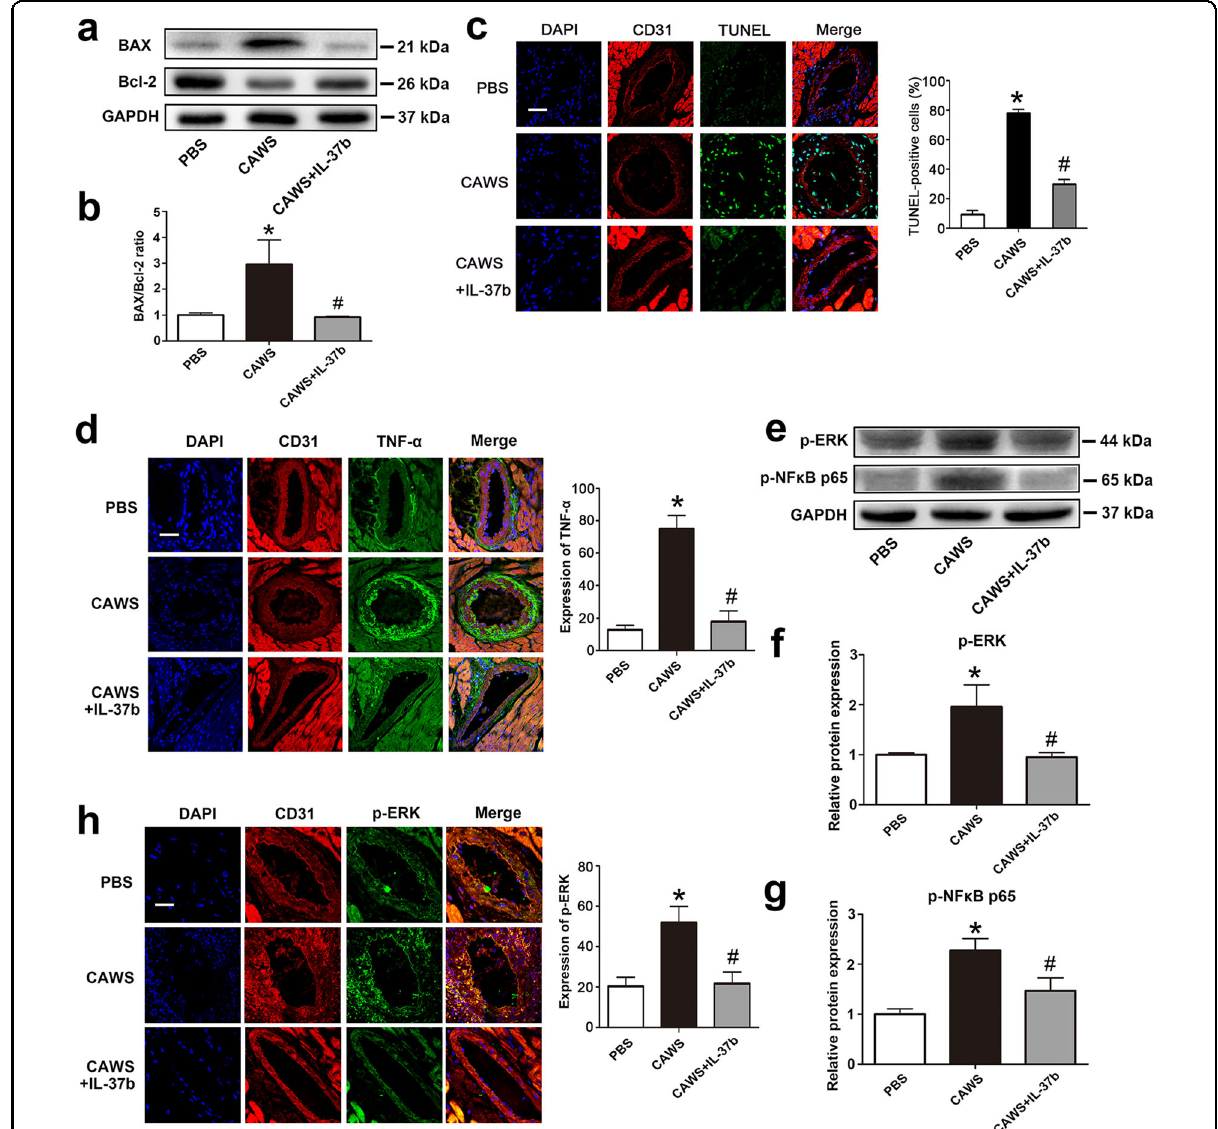
of BAX and Bcl-2 was examined in the KD mouse model after IL-37b treatment ( n = 6). c Effects of IL-37b treatment on DNA fragmentation in the endothelial cells were evaluated by co-localized staining of TUNEL (green) and CD31 (an endothelial marker, red) ( n = 5). Magni fi cation: ×200. Scale bar = 50 μ m. d TNF- α expression levels were examined in the coronary artery endothelial cells by double staining of TNF- α (green) and CD31 (red) ( n = 5). Magni fi cation: ×200. Scale bar = 50 μ m. e – g The activation of ERK and NF κ B was determined in the heart tissues by western blot analysis ( n = 6). h The levels of p-ERK were examined in the coronary artery endothelial cells using p-ERK/CD31 double staining ( n = 5). Magni fi cation: ×200. Scale bar = 50 μ m. Signi fi cance: * P < 0.05 vs. the PBS group, and # P < 0.05 vs. the CAWS group. Each experiment was conducted at least three